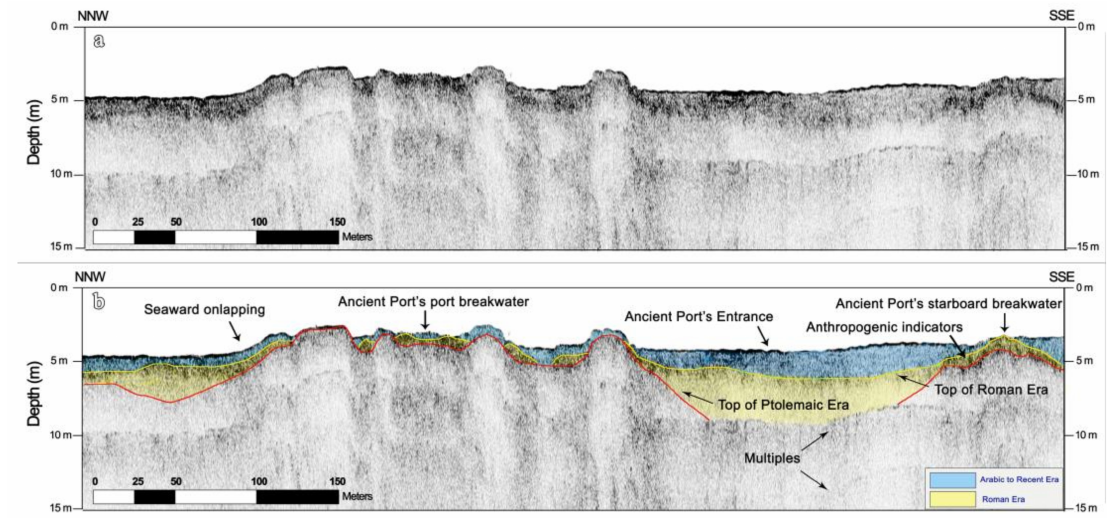
Figure 8. Seismic profile [P] across the breakwaters of the submerged ancient harbor. ( a ) Uninterpreted profile; ( b ) Inter- preted